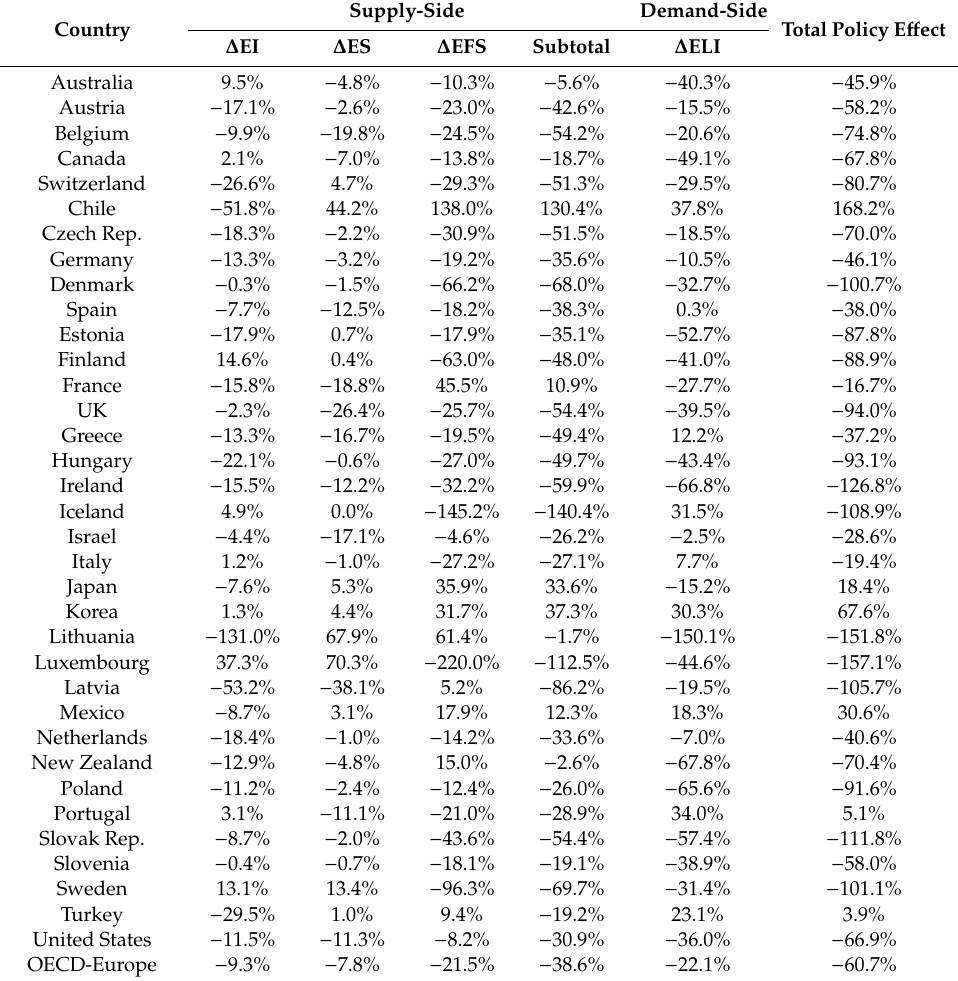
Table 5. The policy e ff ect of CO 2 emission rate of change in power sector of OECD, 1995–2017.